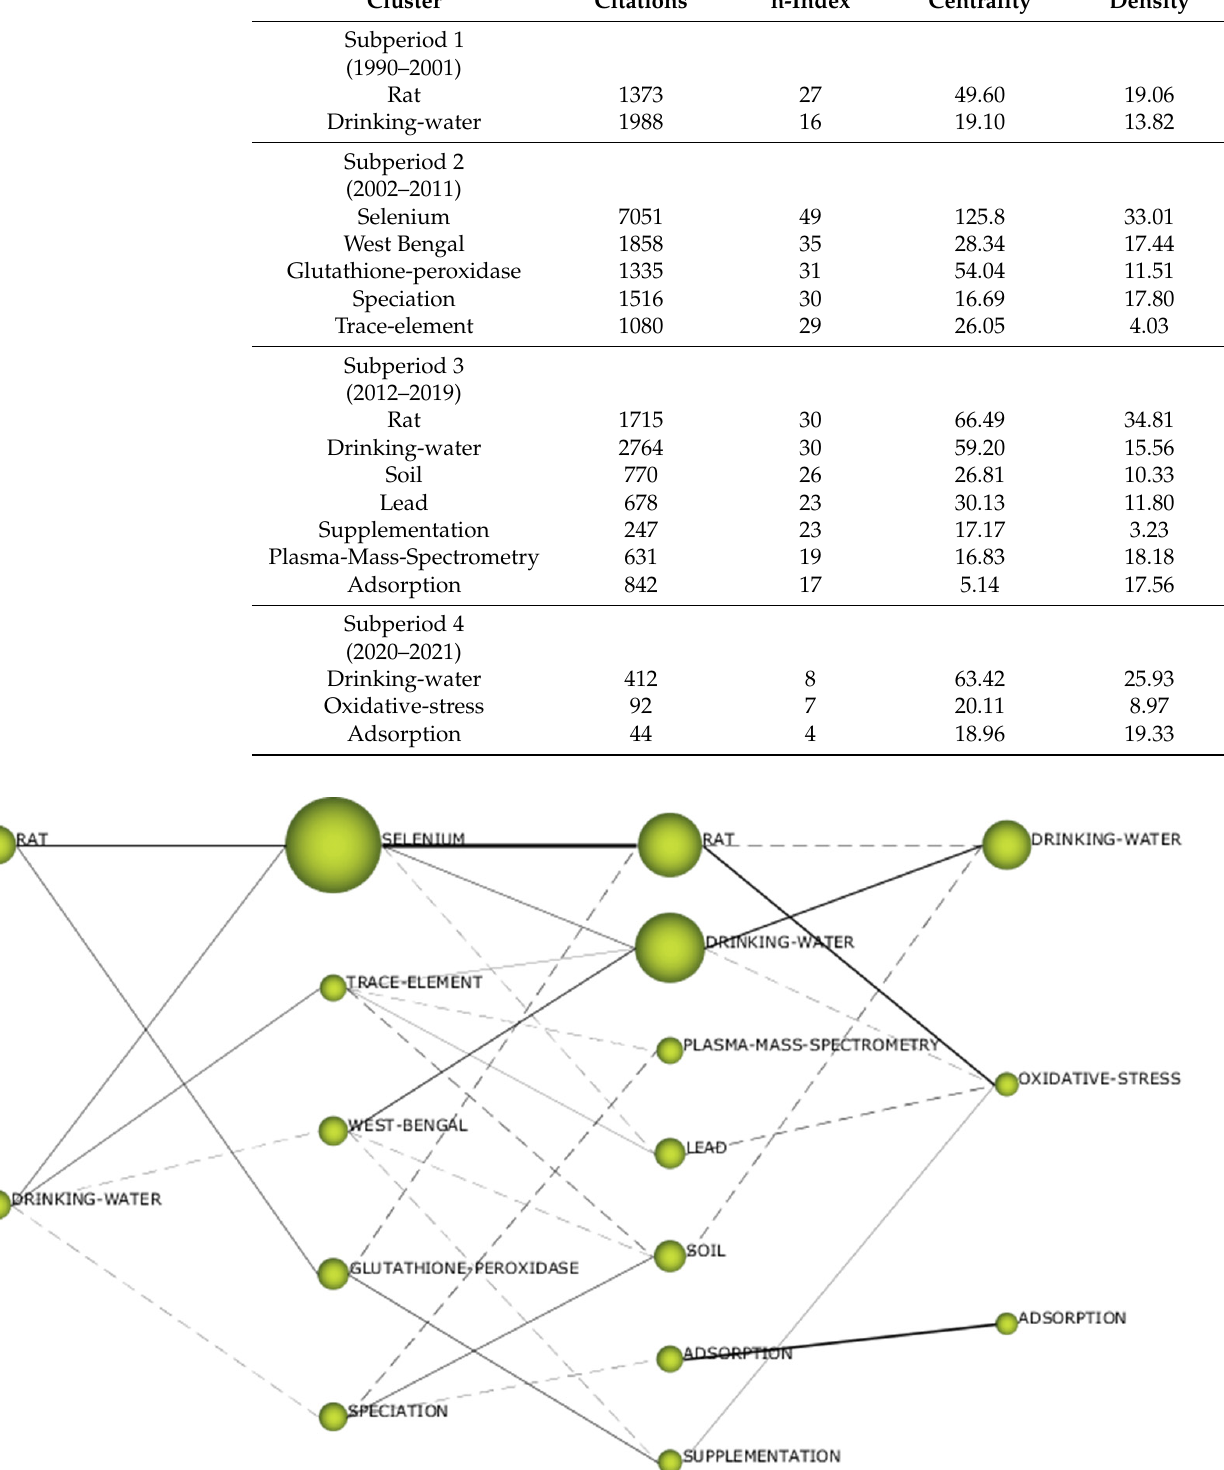
Figure 6. Evolution of the thematic network structure of the clusters Rat/Selenium/Oxidative-stress : 1990–2001 ( a ), 2002–2011 ( b ), 2012–2019 ( c ) and 2020–2021 ( d ).